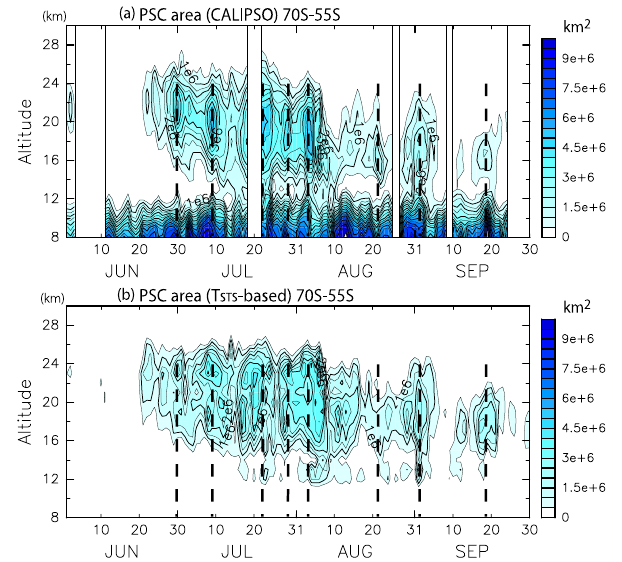
Fig. 8. Time-altitude sections of (a) PSC areal extent obtained from CALIPSO observations and (b) T STS -based PSC areal extent in the latitude range of 55 ◦ S–70 ◦ S in 2008. Broken lines show timings when observed PSC areal extent is maximized. Thin solid lines show the time periods during which CALIPSO data are missing. Contour intervals are 5 × 10 5 km 2 .